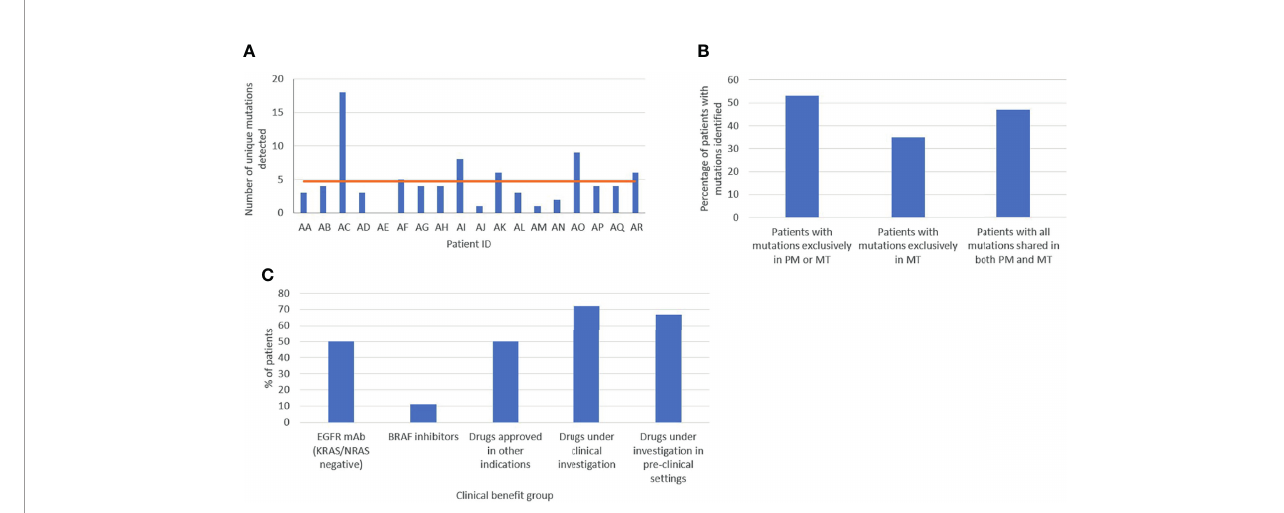
FIGURE 4 | Assessment of tumor heterogeneity (A) Total number of variants per patient in the cohort. (B) Molecular heterogeneity between primary (PM) and metastatic (MT) lesions. (C) Clinical actionability of genetic fi ndings. Based on the variants identi fi ed, patients were allocated in different clinical bene fi t groups: EGFR monoclonal antibody (mAb), BRAF inhibitor, drugs approved in other indications, and drugs under clinical and pre-clinical